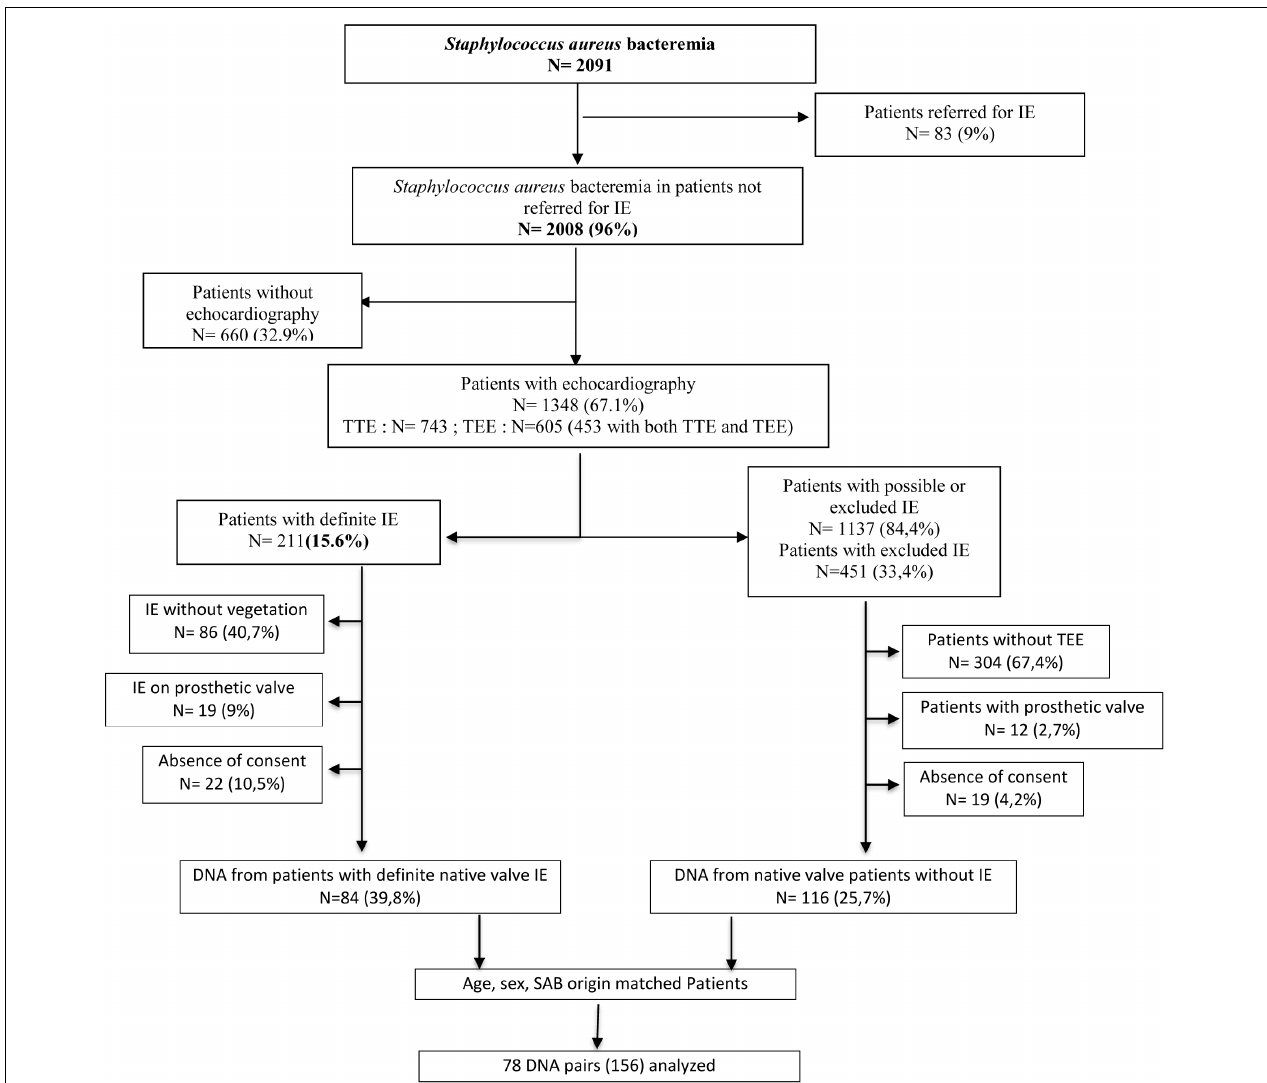
FIGURE 1 | Flow chart of patient recruitment in the VIRSTA case control study. IE, Infective endocarditis. TEE, Transesophageal echocardiography. TTE, Transthoracic